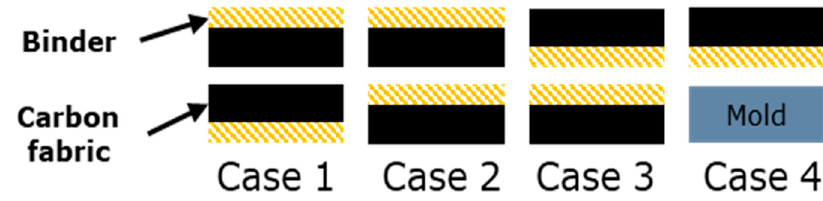
Figure 5. Test cases of the coefficient of friction of carbon fabric.